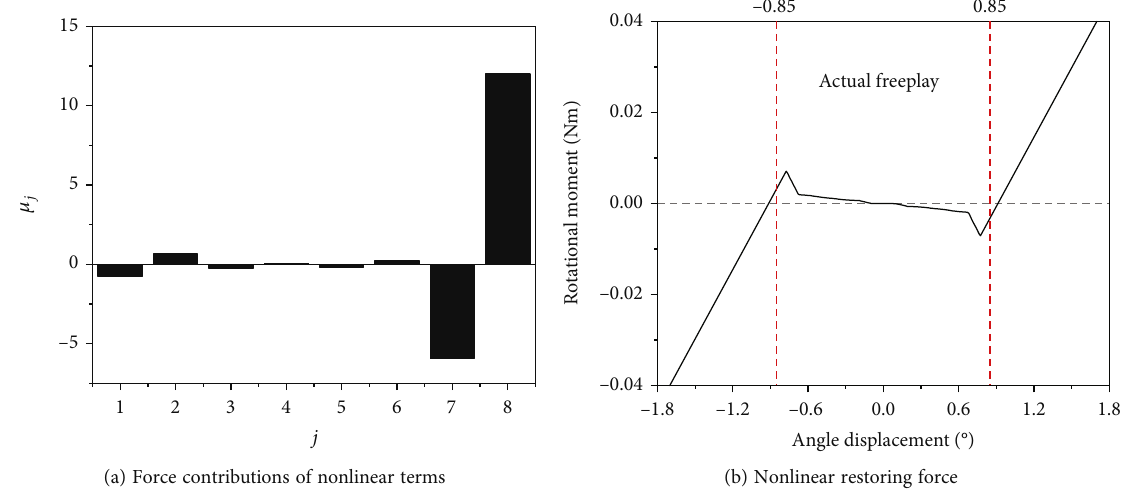
Figure 13: Parameter estimation by TNSI method.